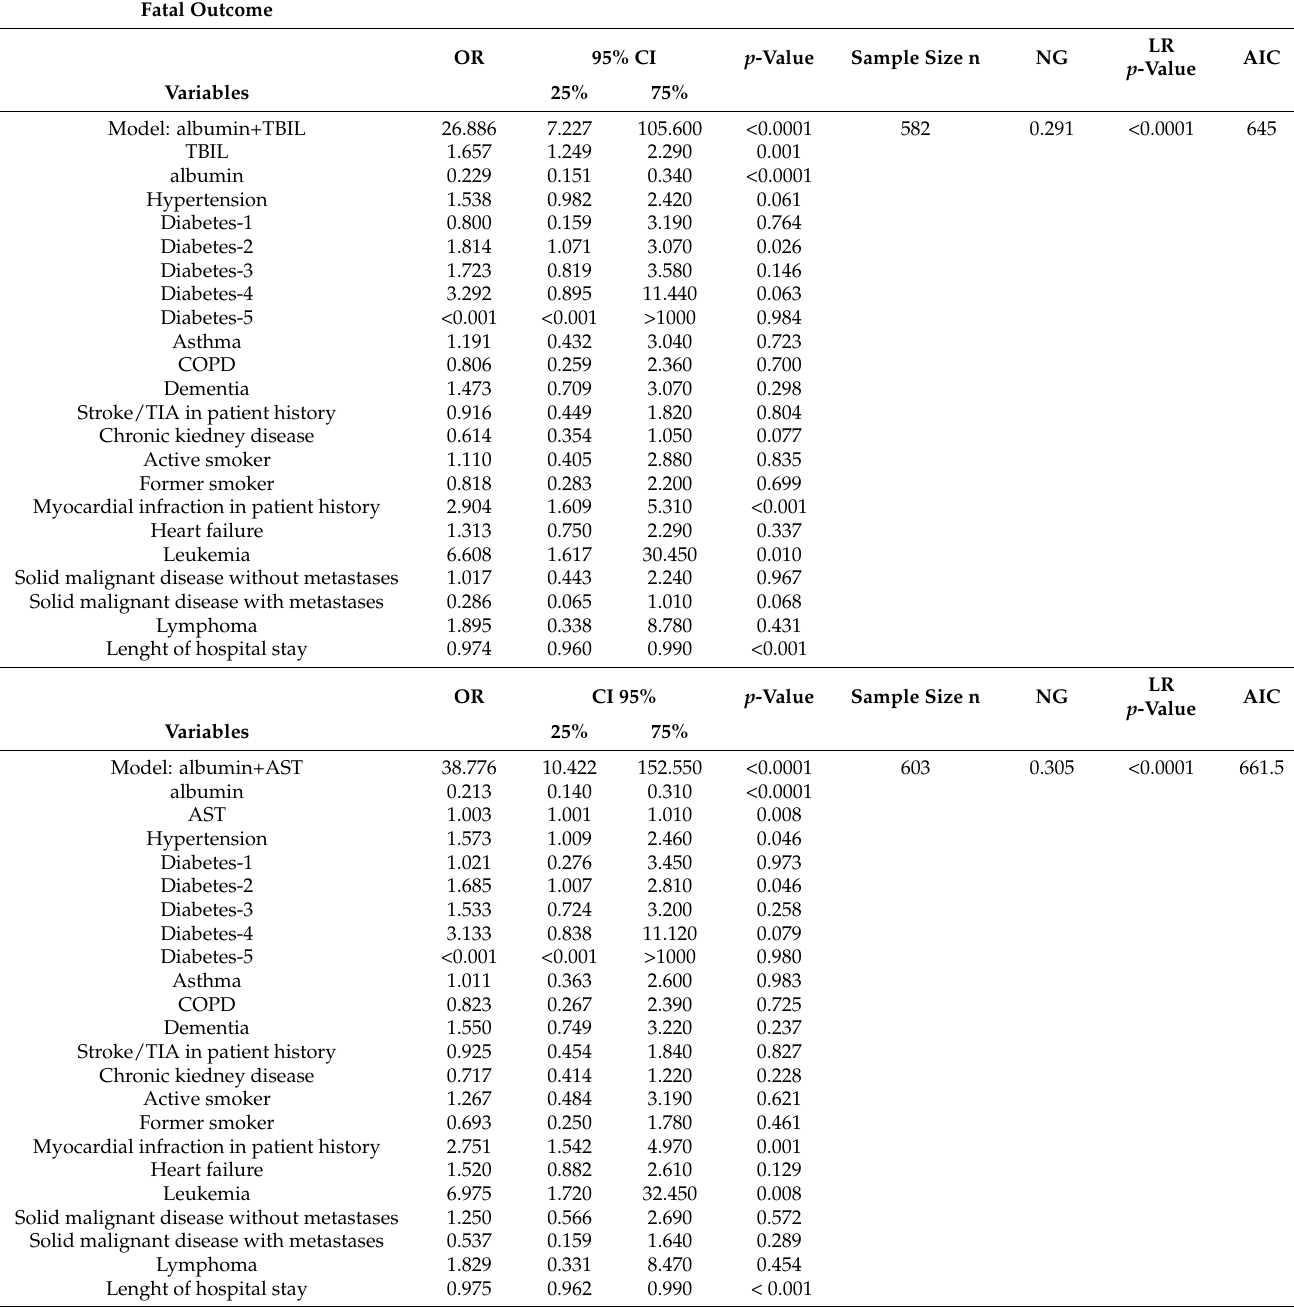
Table 7. The best models to predict fatal outcomes in COVID-19 tested on larger groups of